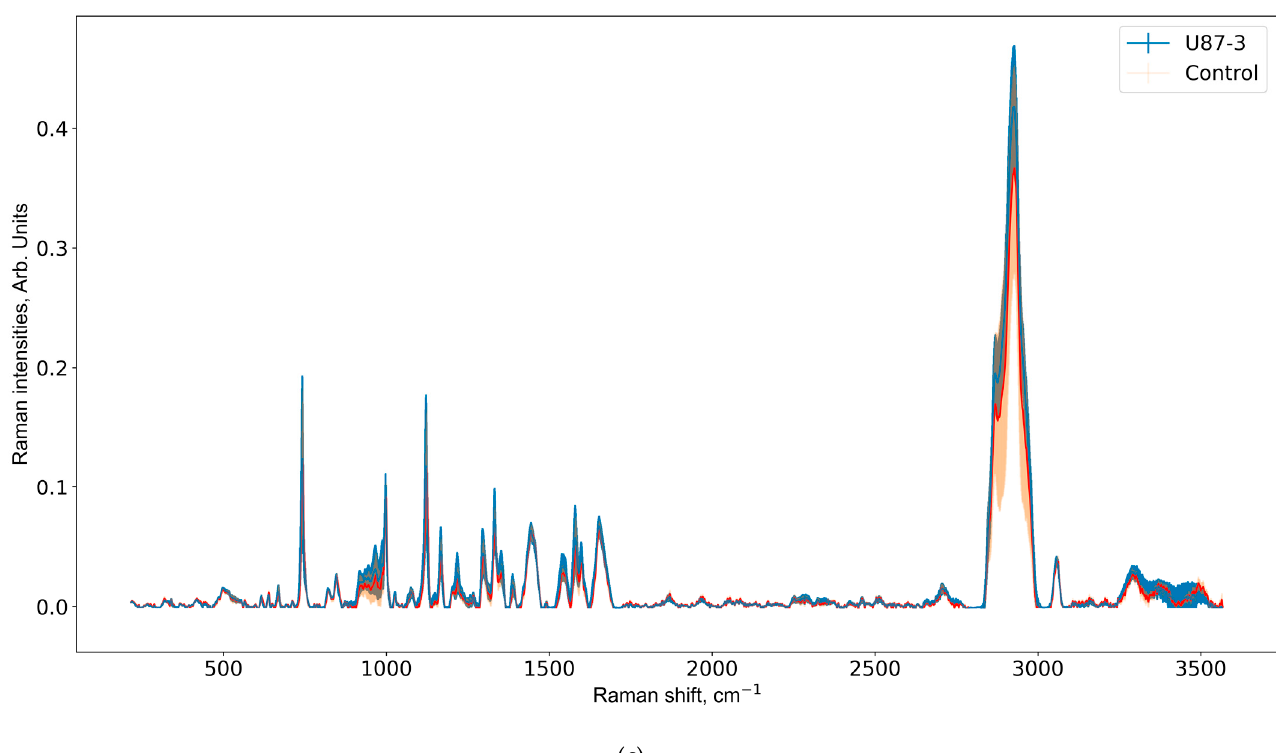
Figure 3. Mean and standard deviation of Raman spectra of U87-1, U87-2, U87-3, and control groups for first ( a ), second ( b ), and third ( c ) weeks of the experiment. Subtracting standard deviation from the mean may lead to negative values, which were then removed.